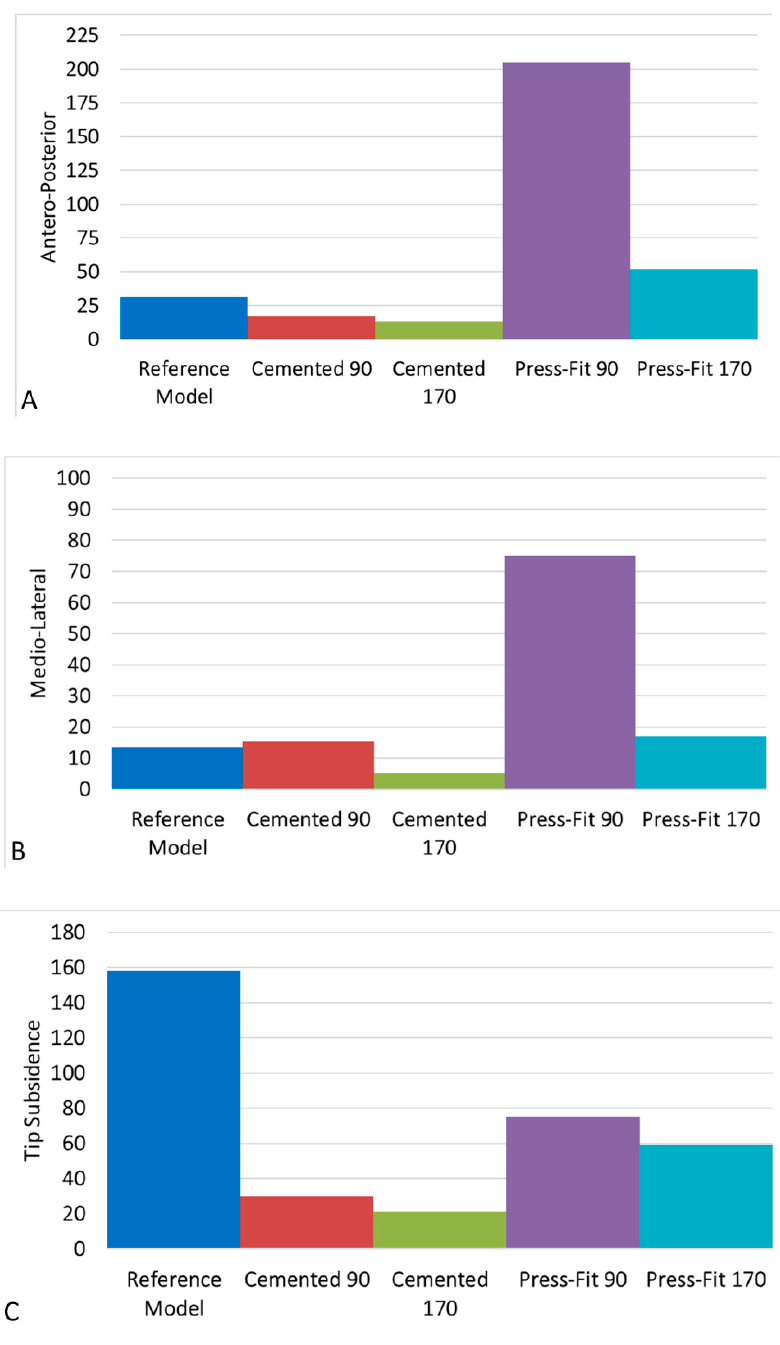
Figure 8. Implant/bone micromotions calculated for all the configurations and compared with reference model ones: antero-posterior ( A ) and medio-lateral ( B ) implant micromotions at the bone-implant interface; stem tip subsidence ( C ).